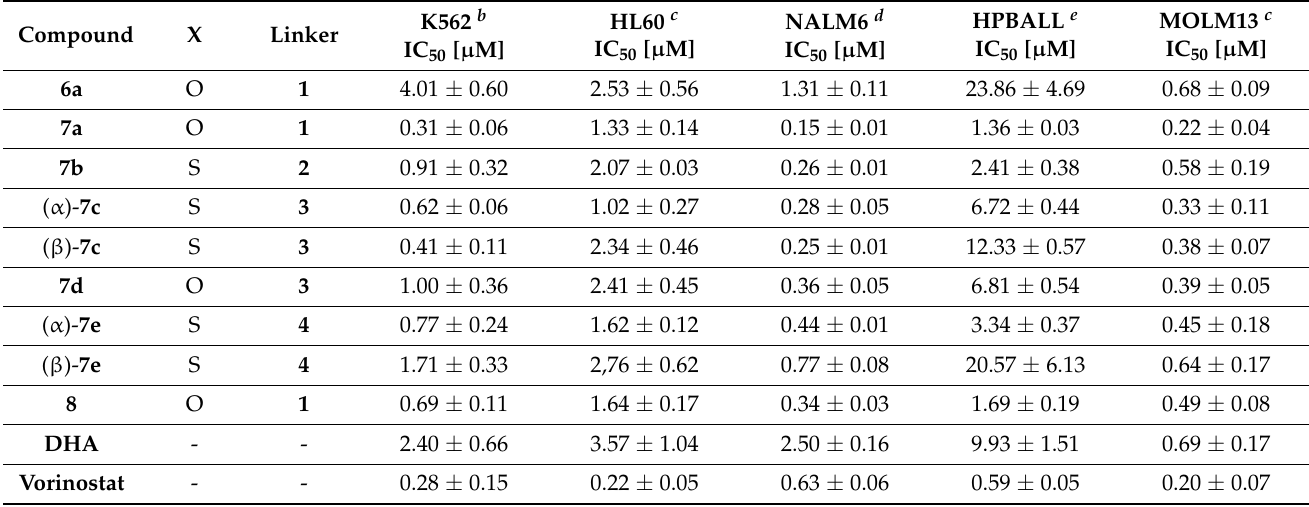
Table 3. IC 50 Values of DHA–HDACi hybrids for different leukemia entities a